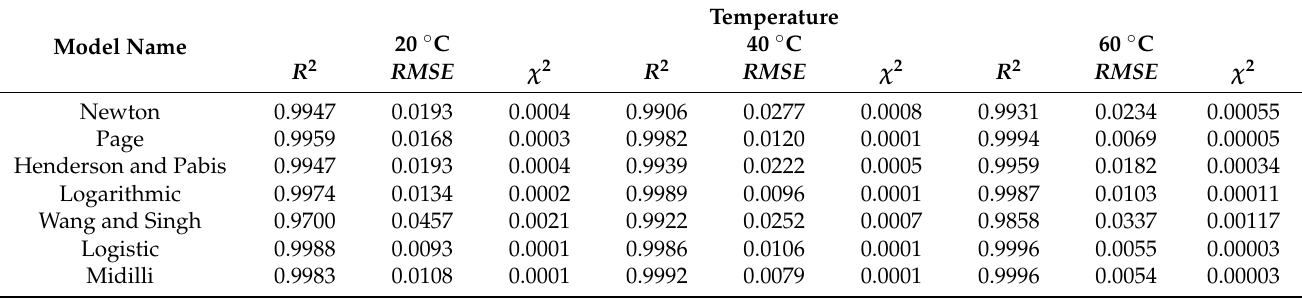
Table 2. Statistical analysis of models describing kinetics of freeze-drying of strawberry slices.